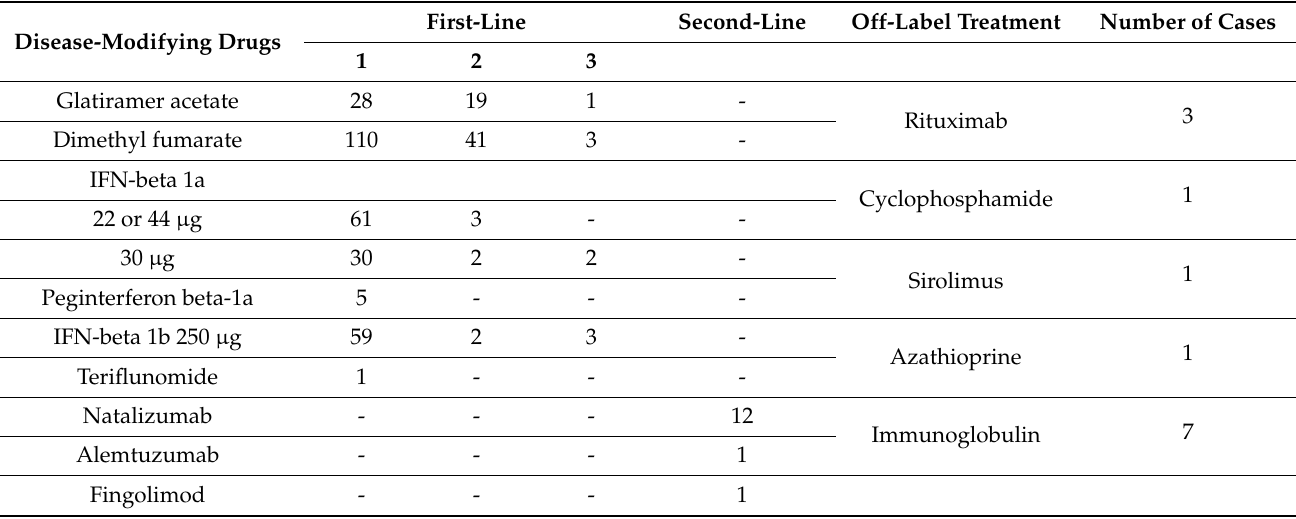
Table 4. List of DMDs in use for POMS between 2015 and